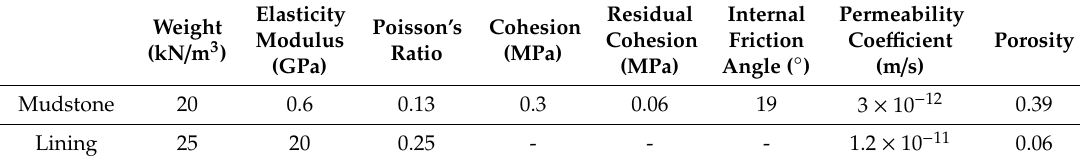
Table 1. Material parameters of finite element model.